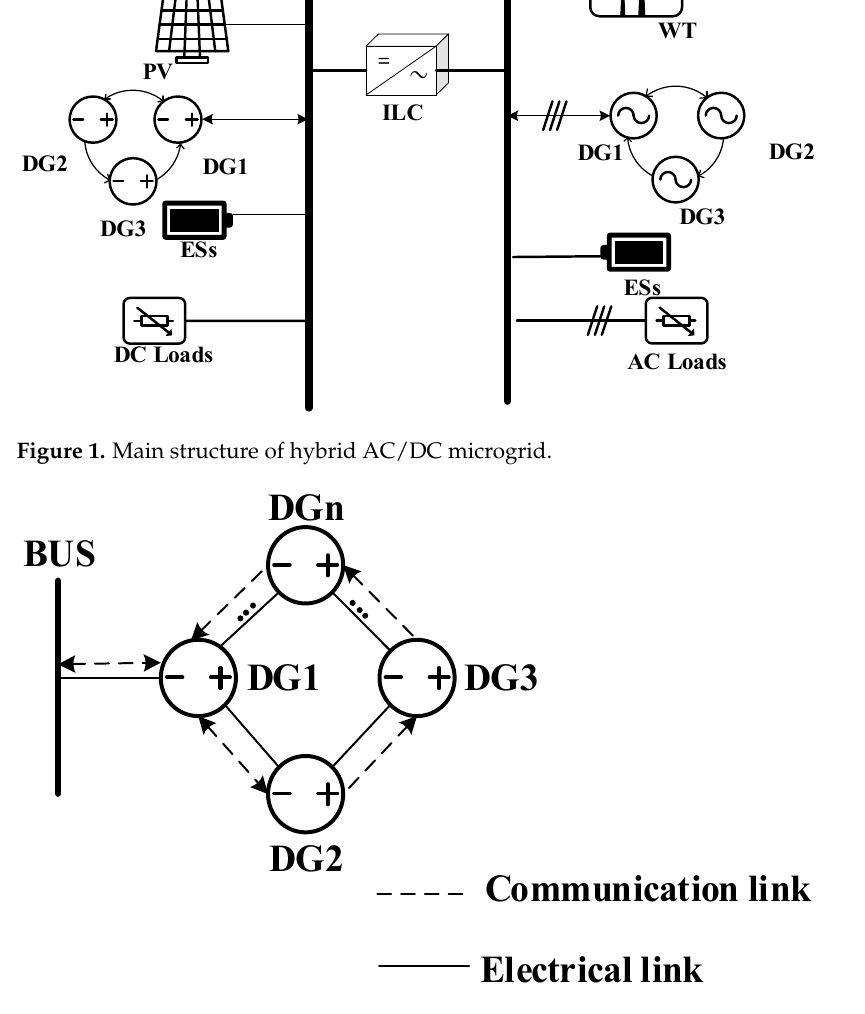
Figure 1. Main structure of hybrid AC/DC microgrid.